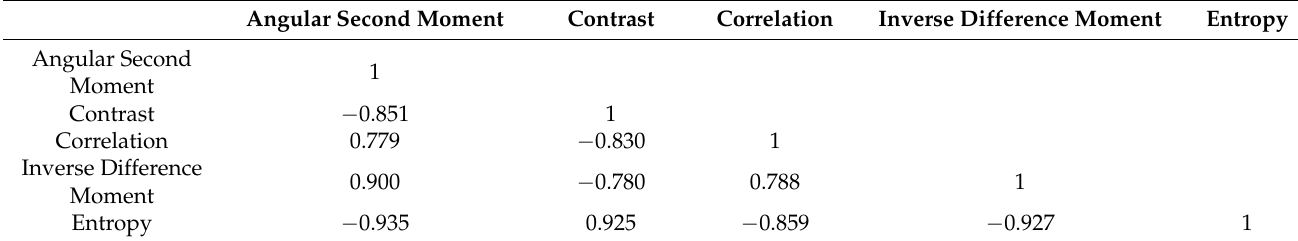
Table 3. The correlation matrix of set Z1.